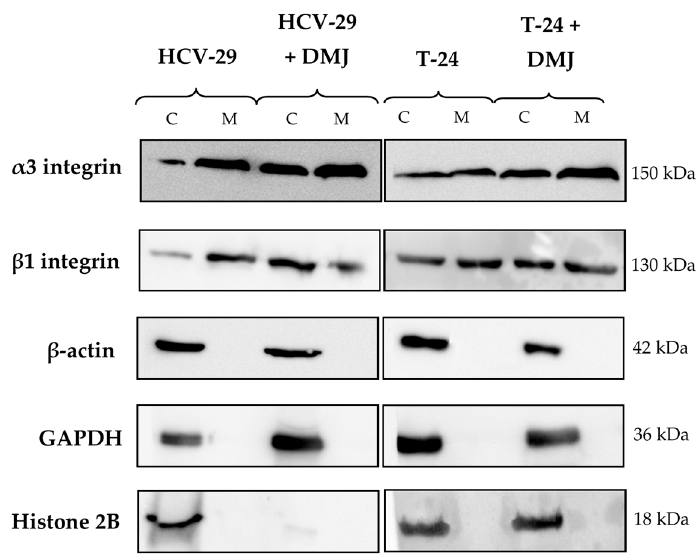
Figure 2. Assessment of the membrane fraction purity. On-blot immunodetection of proteins representative for each subcellular fraction was performed for the whole cell protein extracts (C) and the membrane fractions (M) obtained from HCV-29 and T-24 cell lines grown in control conditions and treated with DMJ. Loading controls: anti- α 3 integrin subunit and anti- β 1integrin subunit (for the membrane fraction), anti- β -actin (for the cytoskeletal fraction), anti-histone 2B (for the nuclear fraction), anti-GAPDH (for the cytosolic fraction).